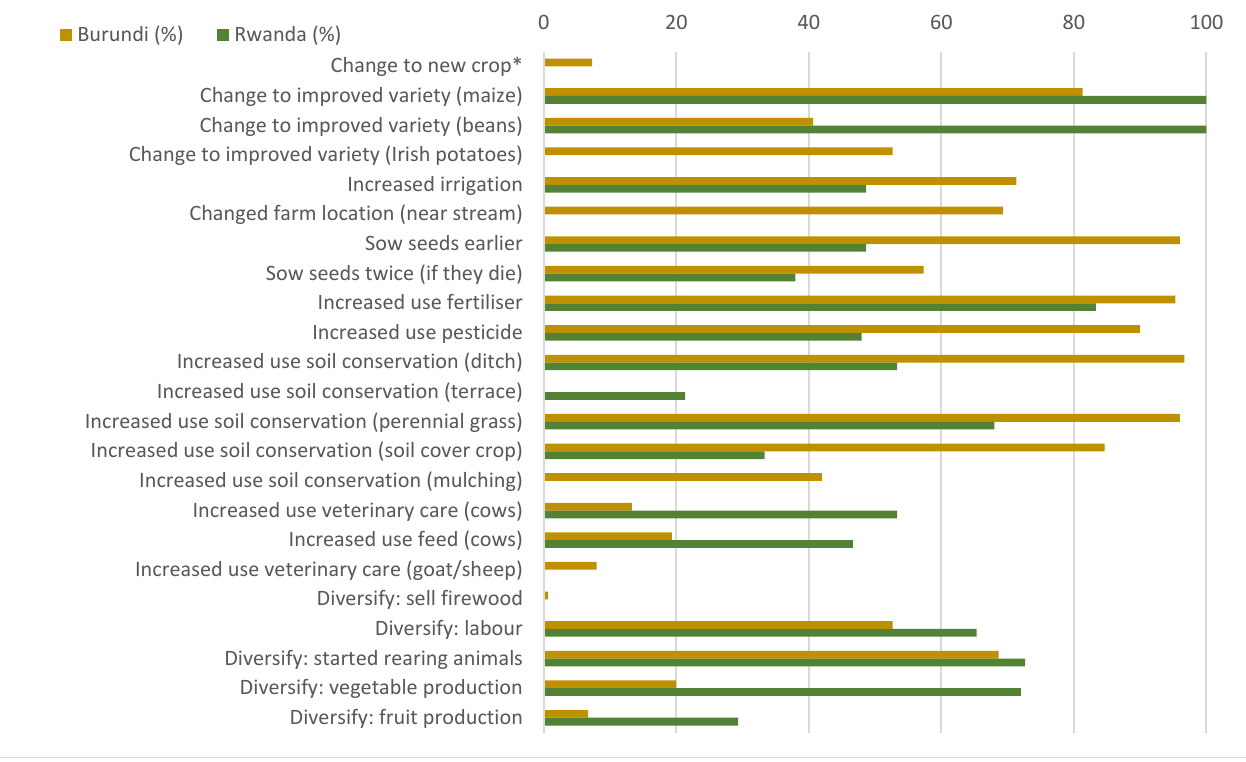
Figure 4. Adaptation strategies used regarding percent of respondents in each study area (Burundi n = 150, Rwanda n = 150). *New crops refer to sweet potatoes, cassava, or wheat. Note that we did not ask about improved Irish potatoes in Rwanda.